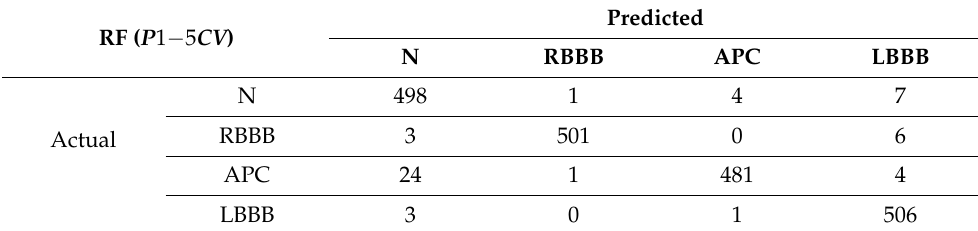
Table 5. Confusion matrix for the RF classifier applied to the P 1 dataset within the 5CV protocol (Accuracy = 97.35%).